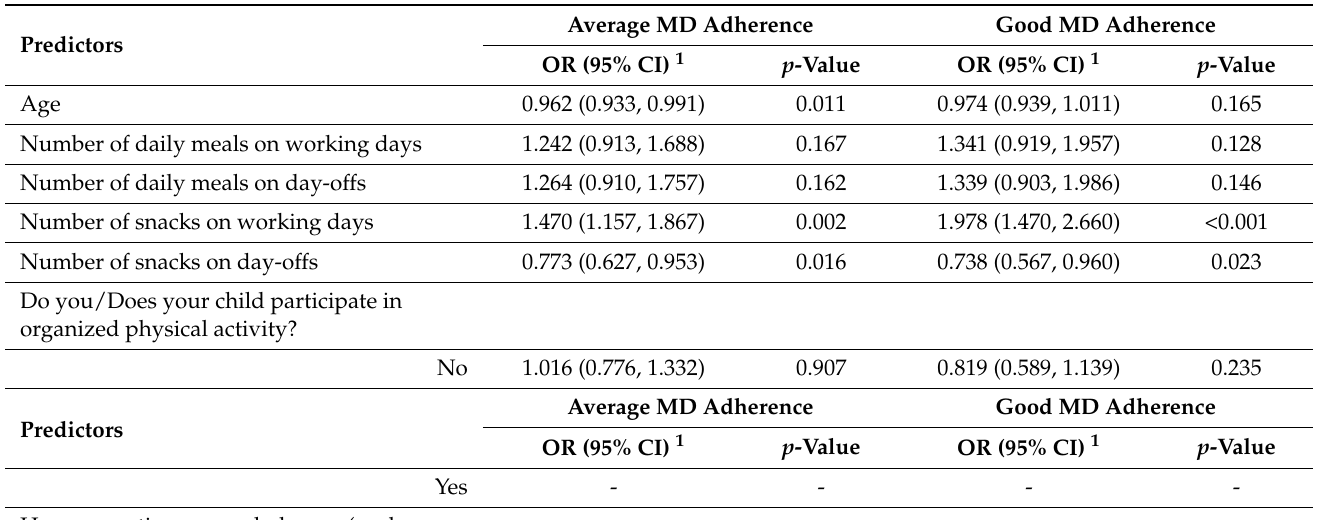
Table 3. Results of the multinomial logistic regression with categories of MD adherence as a depen- dent